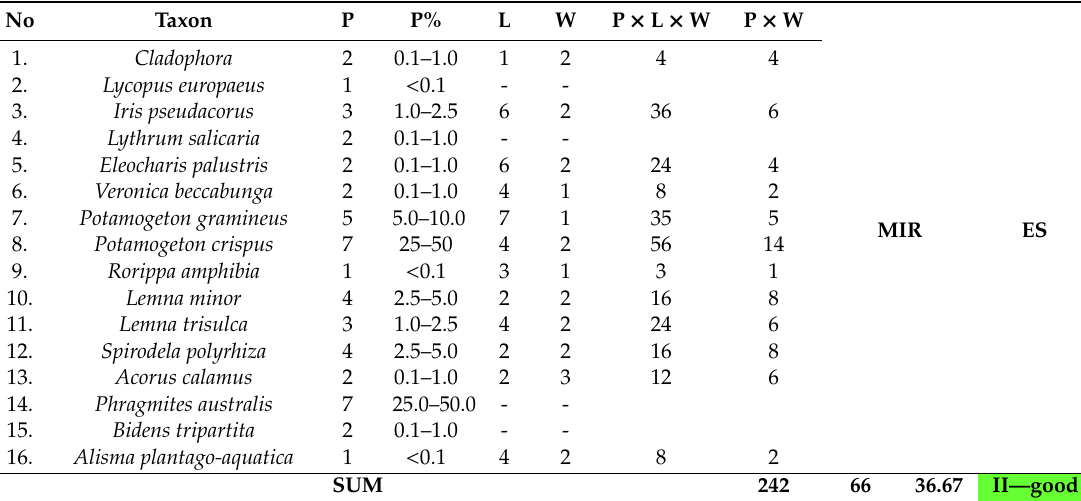
Table 6. Summary of MMOR results, May 2017, reference section on the ´Sl˛eza (P—taxon cover scale,